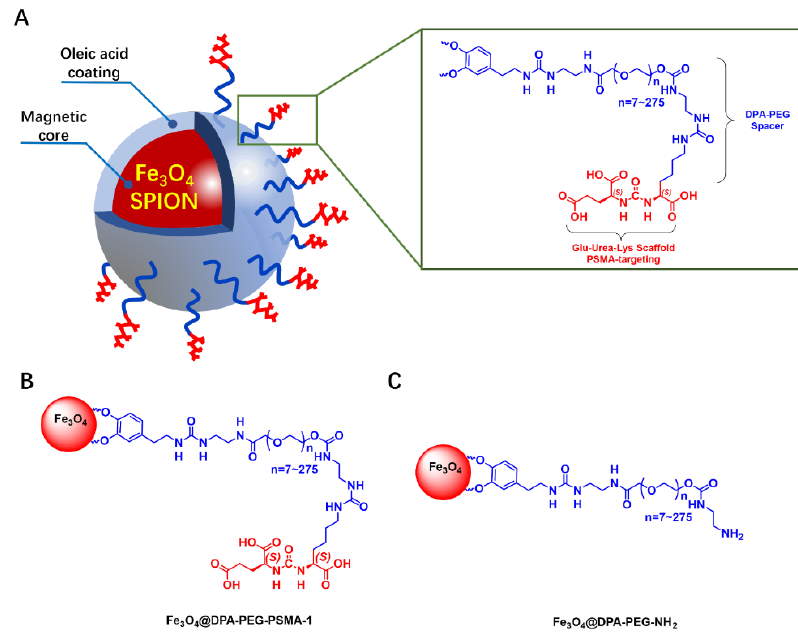
Figure 1. Design of the PSMA MRI probe and the negative control probe. ( A ) a schematic illustration of Glu-Urea-Lys scaffold functionalized SPION probe for MRI of PCa. ( B , C ) SPIONs labelled with/without PSMA-targeting Glu-Urea-Lys scaffold (PSMA-1).